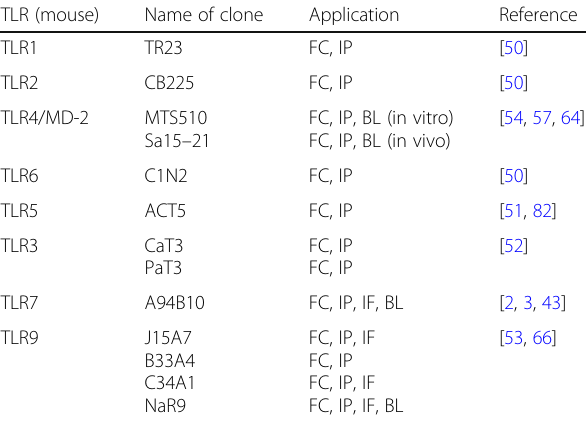
Table 2 Application of anti-monoclonal antibodies we established TLR